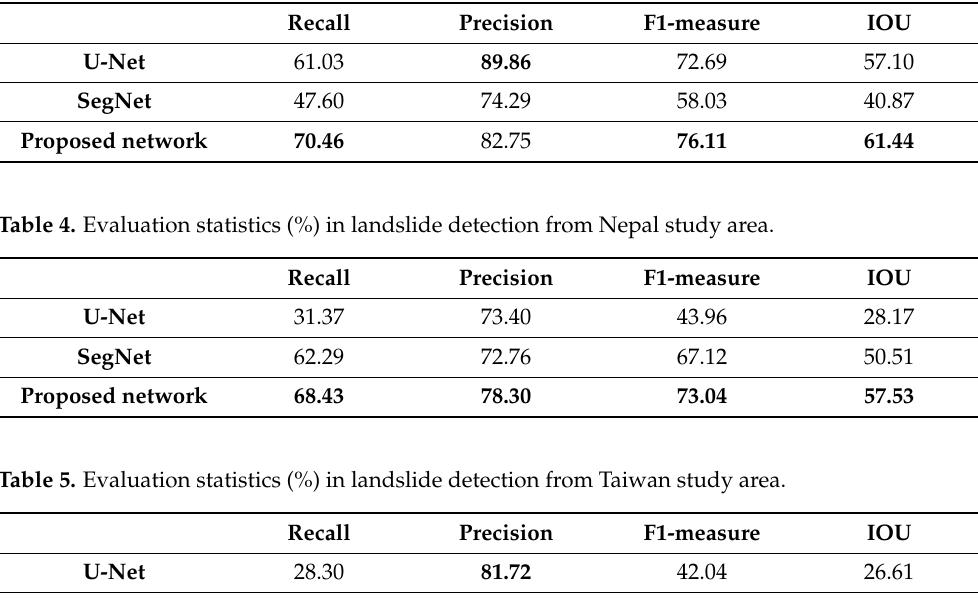
Table 3. Evaluation statistics (%) in landslide detection from Jiuzhaigou study area.